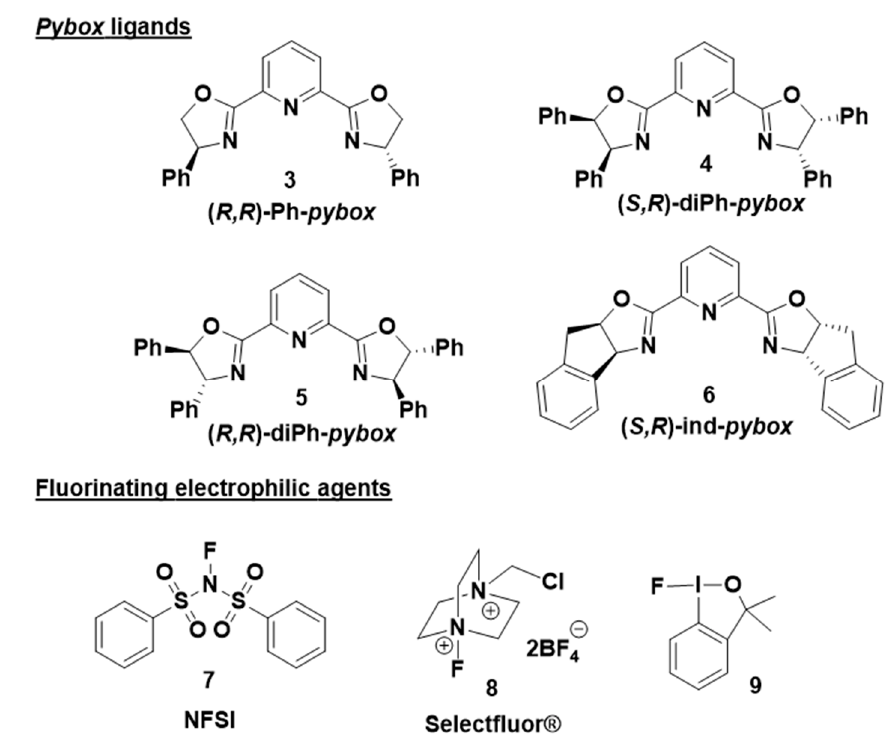
Figure 1. Fluorinating agents and pybox C2-symmetry ligands used in the optimization of the electrophilic enantioselective fluorination reaction.